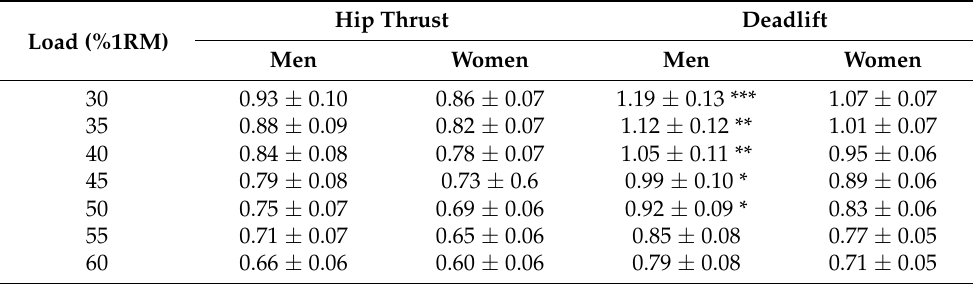
Table 1. Estimated mean propulsive velocity values for each %1RM in the hip thrust and deadlift exercises for men ( n = 16) and women ( n = 16) derived from the individual load–velocity relationships. Load